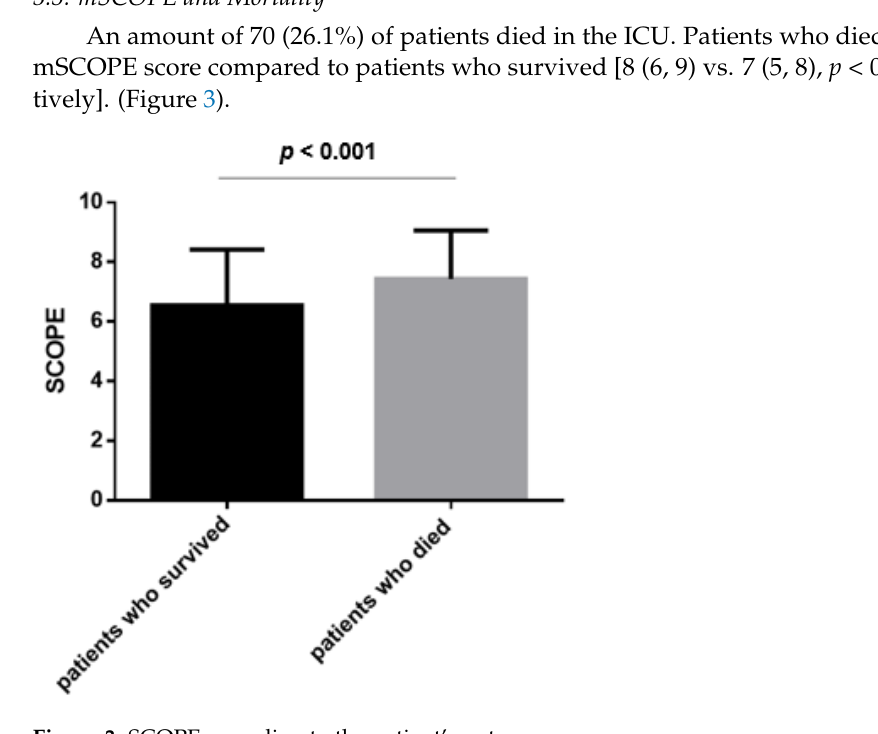
Figure 3. SCOPE according to the patient’s